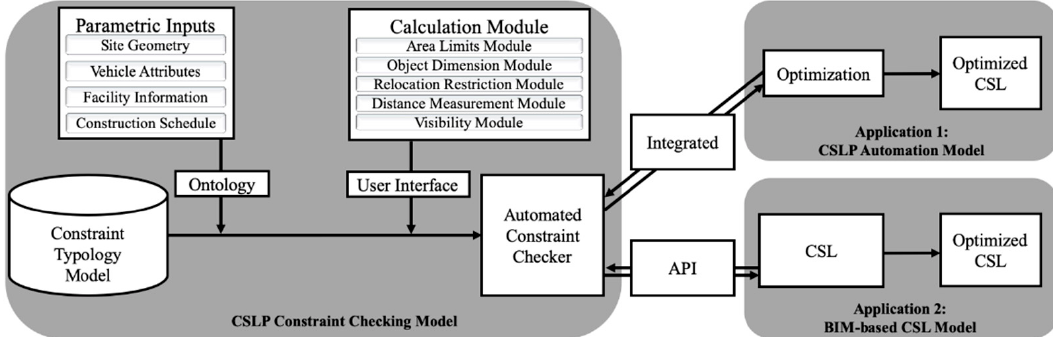
Figure 10. Applying a constraint checker for optimizing construction site layout.